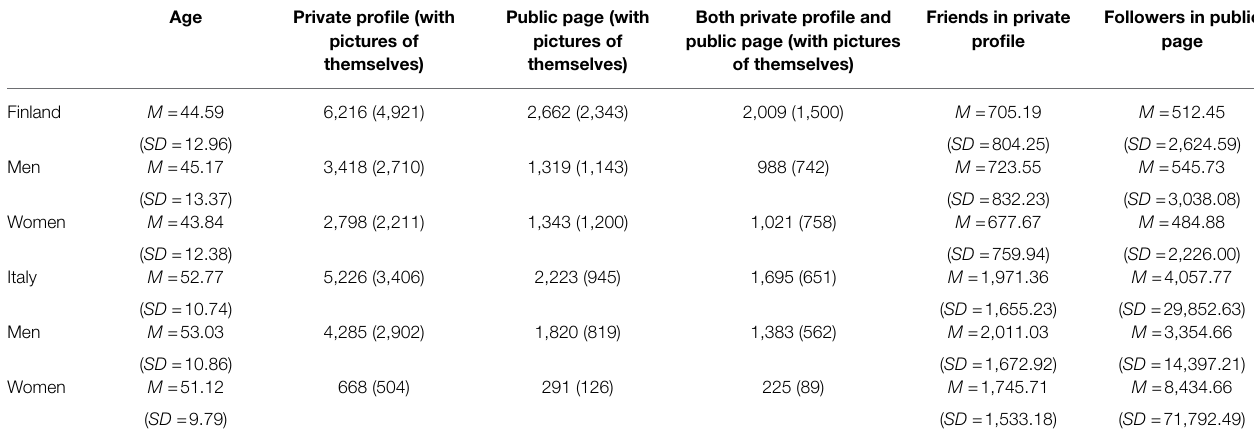
TABLE 1 | Frequencies for private profiles and public pages together with means and SDs for age, friends, and followers divided for country and gender. Age